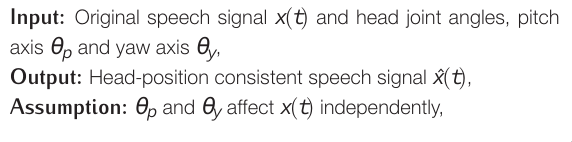
ters the vocal tract, which works as an acoustic filter in accordance with the source filter model [8]. The bending of the vocal tract by the pitch axis rotation rather than the twisting by the yaw axis rotation is considered dominant in the spectral characteristics of the voice signal. The yaw rotation determines the direction of the voice on the azimuth plane without affecting the vocal tract shape. Here, the problem statement is specified below.